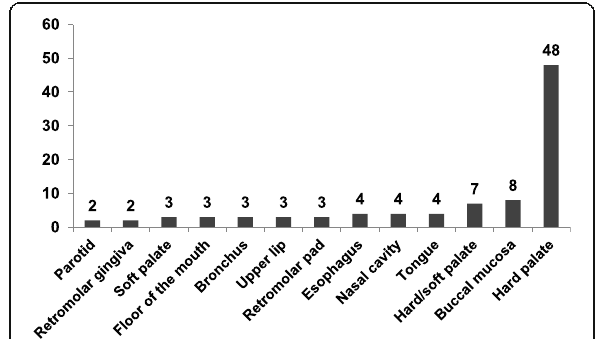
Fig. 1 Anatomic location of sialadenoma papilliferum (94